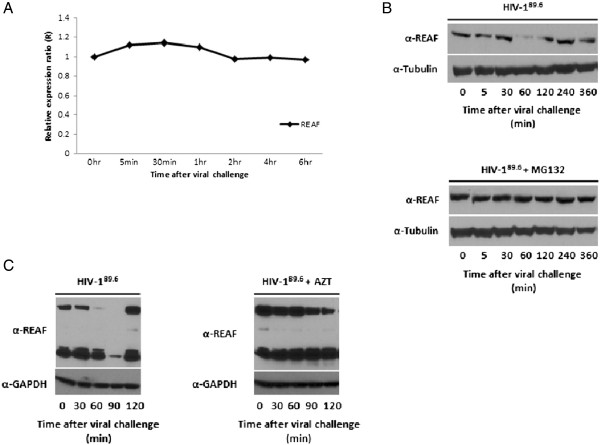
REAF is downregulated in response to HIV-1 infection and restriction requires reverse transcription. (A) Time course of REAF mRNA following challenge with HIV-189.6. qPCR results from analysis of cDNA are normalised to β-actin mRNA levels. (B) REAF protein levels are downregulated following challenge with HIV-189.6. Treatment with MG132 (10 μM) prevents the degradation of REAF protein. Tubulin is included as a loading control. Only the lower band of REAF (80 kDa) is shown – not all bands are detected in all experiments. (C) Following treatment with AZT (100 nM), challenge with HIV-189.6 no longer causes depletion of REAF at 1 hr pi. GAPDH is included as a loading control.